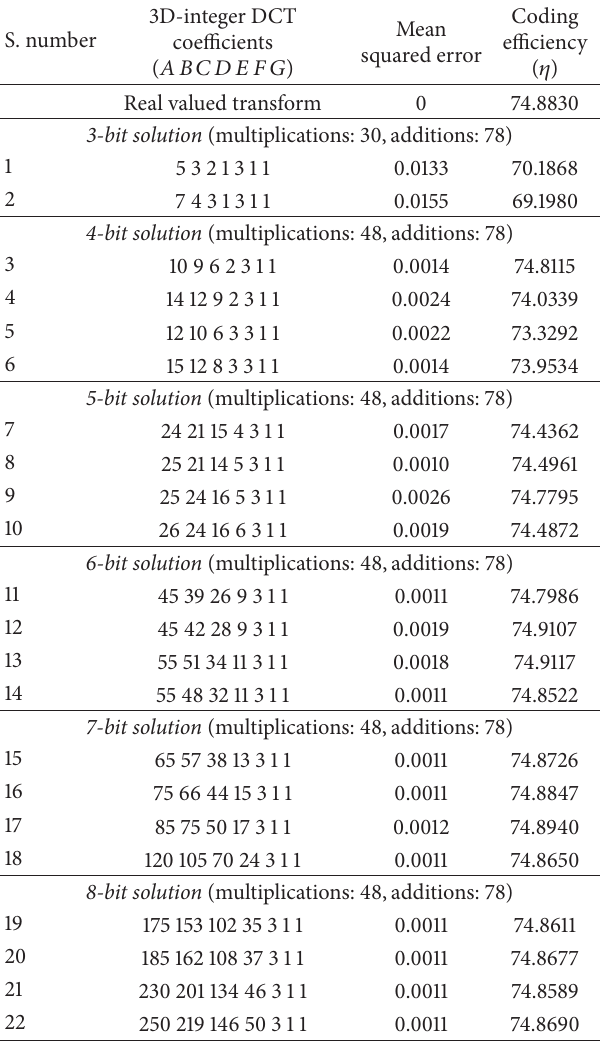
Table 2: MSE and coding efficiency of 3D-integer DCT computed using direct